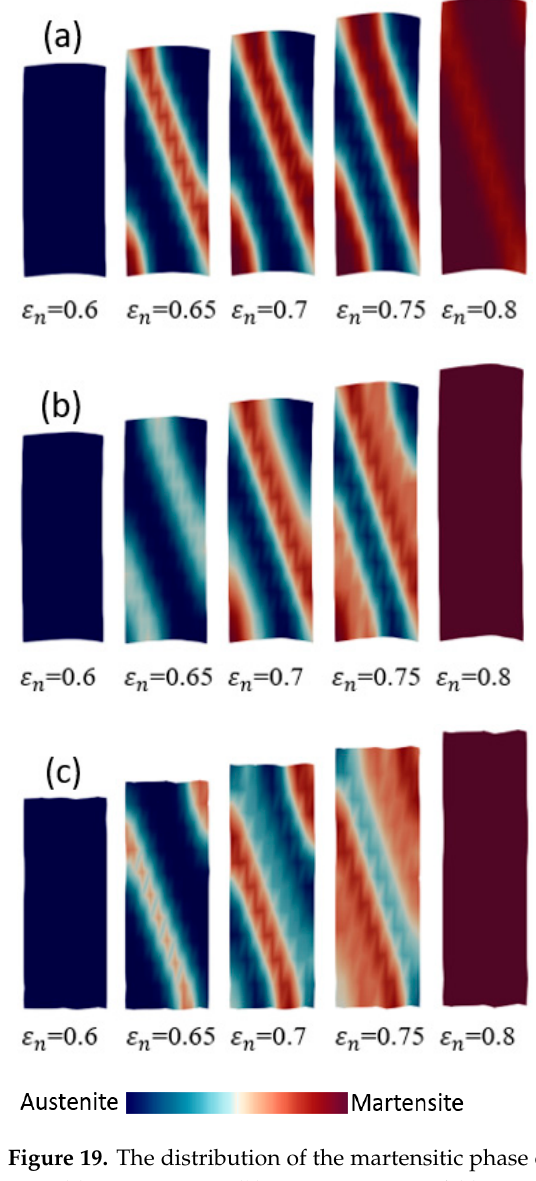
Figure 19. The distribution of the martensitic phase of single crystal TRIP steel with different cell sizes ( a ) 0.1 × 0.1 mm, ( b ) 0.5 × 0.5 mm, and ( c ) 1.0 × 1.0 mm.